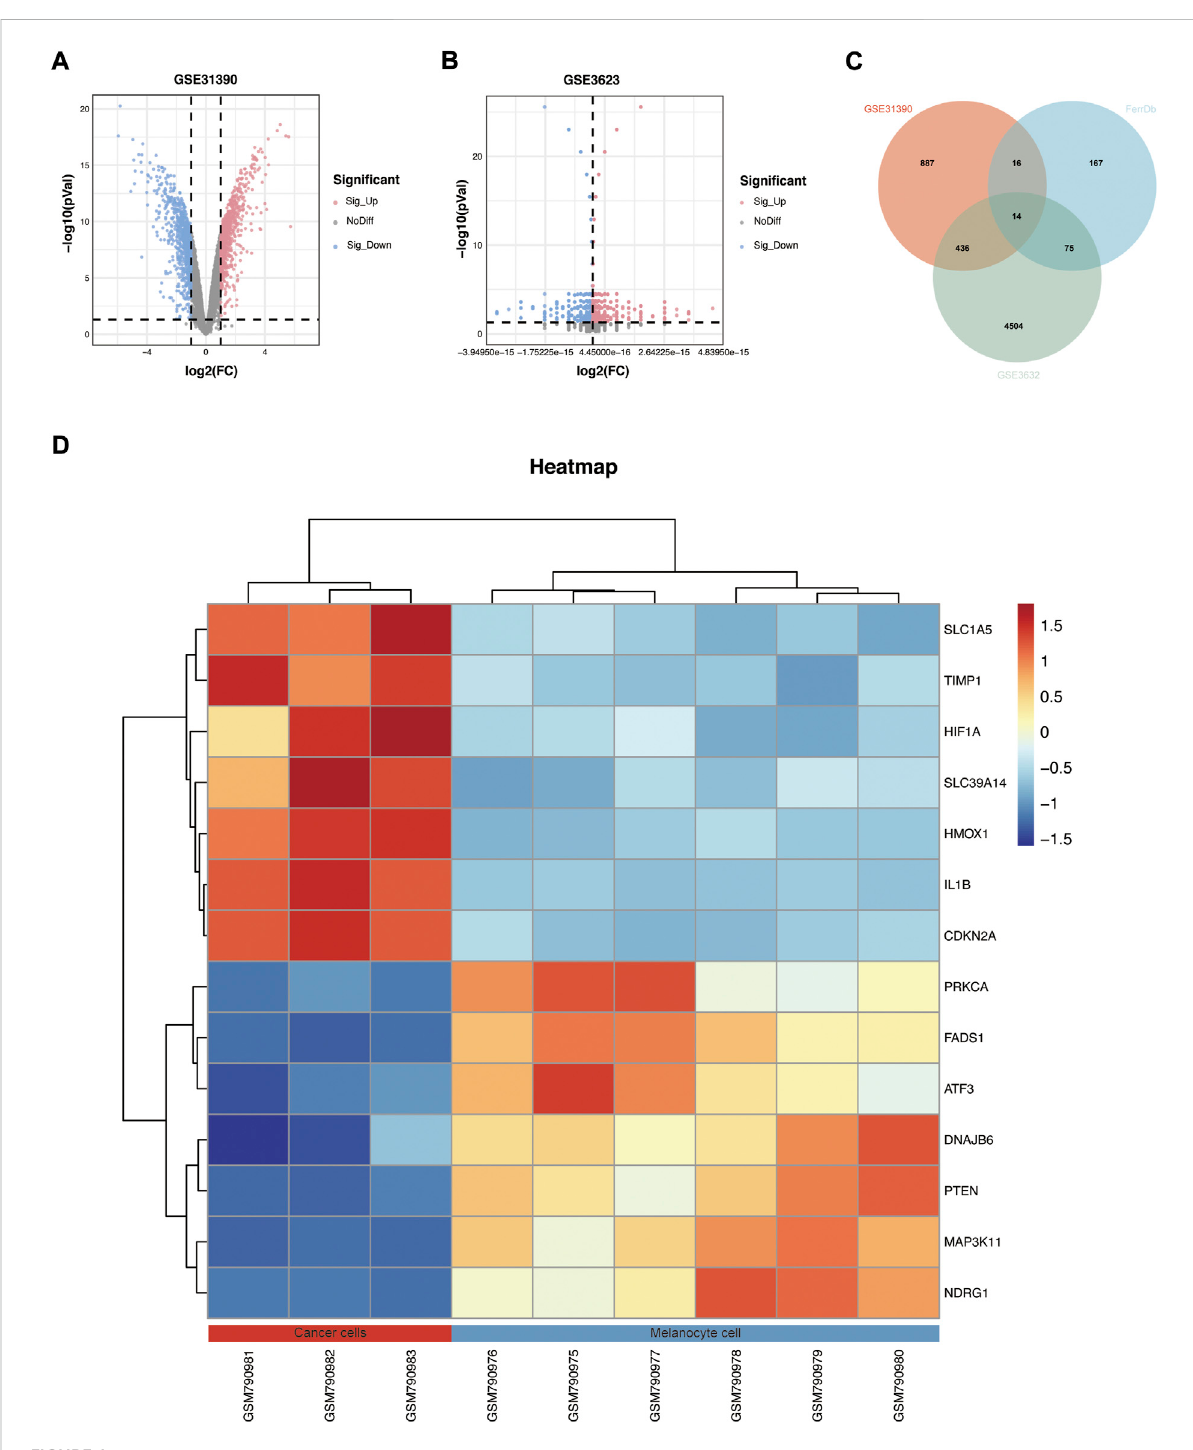
FIGURE 1 Identi fi cation of DEGs. (A,B) Volcano map of GSE31909 and GSE3632. (C) Venn diagram showed the intersection of common DEGs from the two datasets and ferroptosis-related genes. (D) Heatmap showed all common DEGs in